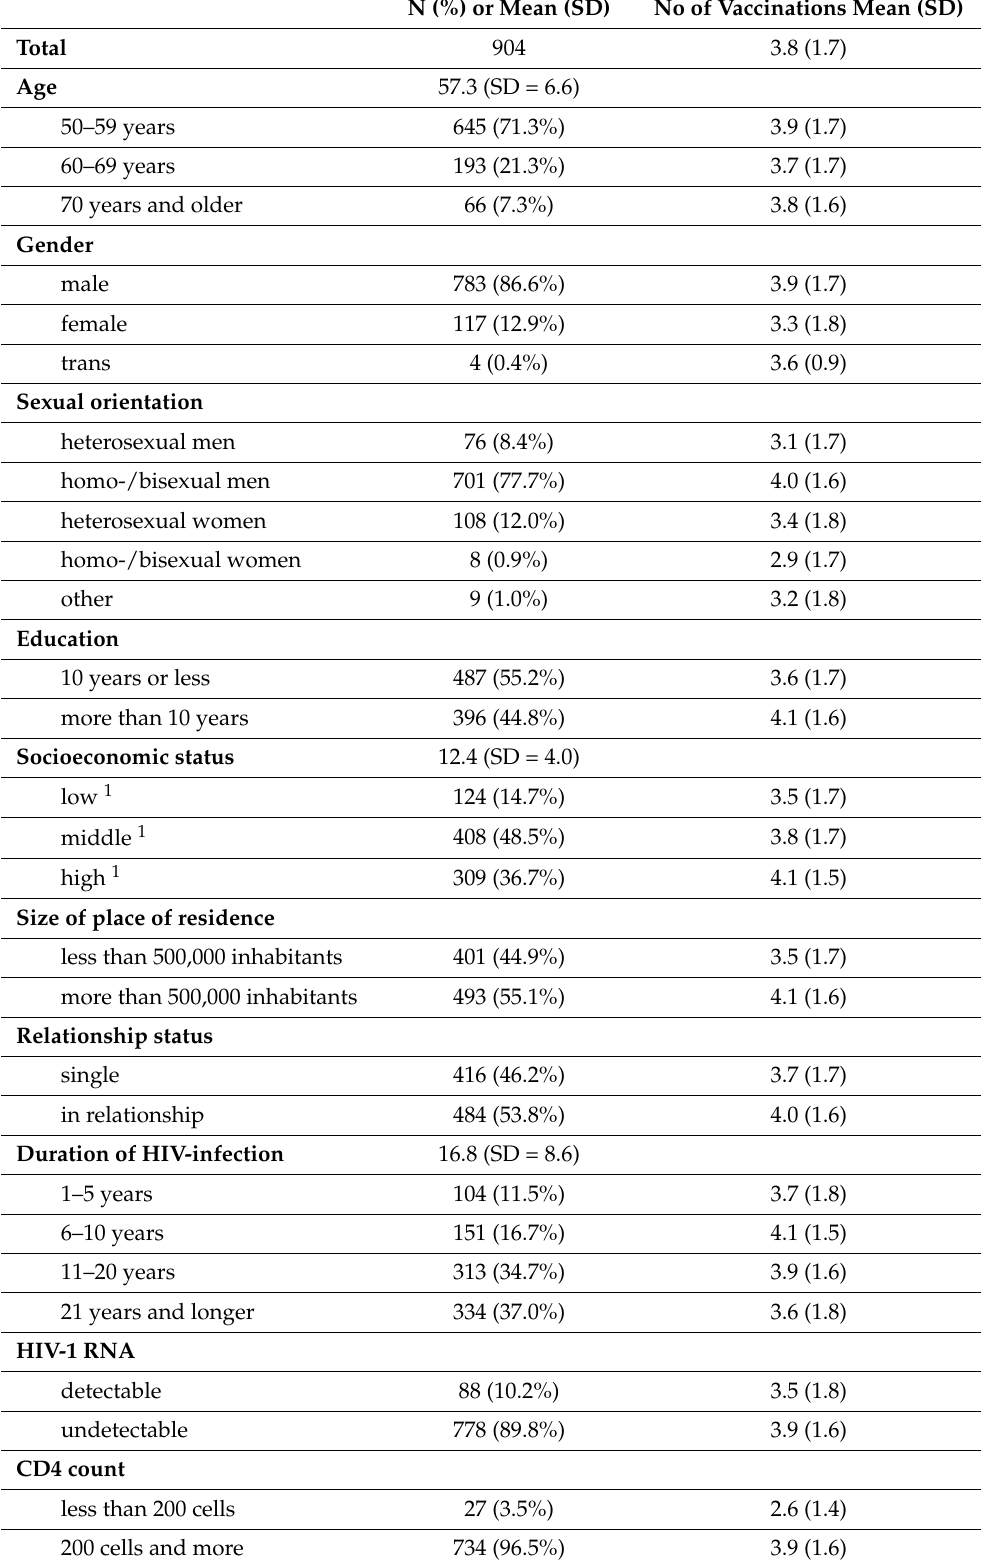
Table 1. Sample characteristics and number of self-reported vaccinations for each subgroup (n =